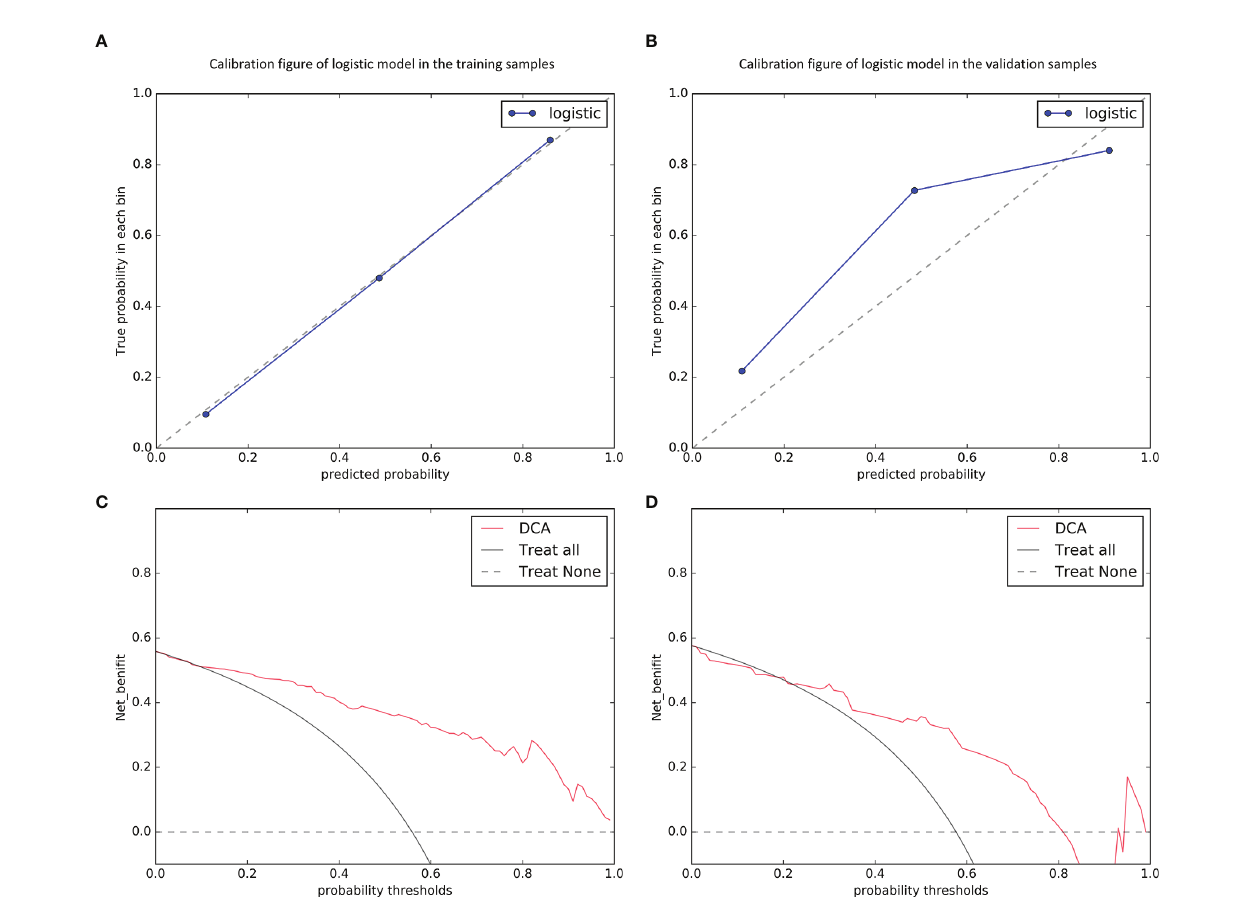
FIGURE 5 | Calibration curves of the combined model in predicting microvascular invasion status on the training (A) and validation (B) datasets, which demonstrated good agreement with the ideal curve. The net bene fi t of the decision curve analysis (DCA) for the combined model was higher than the measures that treat all patients and treat none patient when the threshold probabilities were within 0.097 – 1.000 in the training dataset (C) and 0.219 – 0.806 in the validation dataset (D)